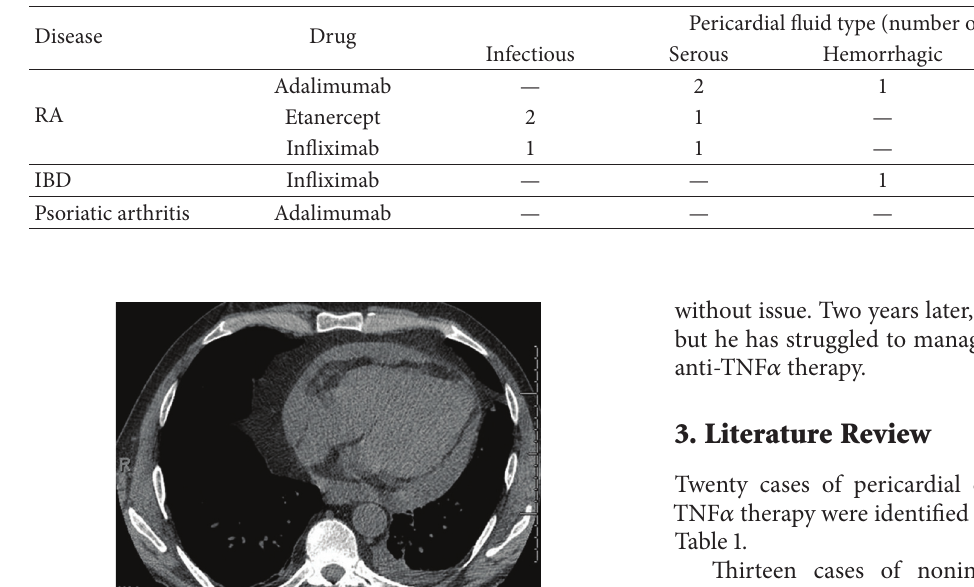
Table 1: Anti-TNF 𝛼 -associated pericardial complications (including our case).